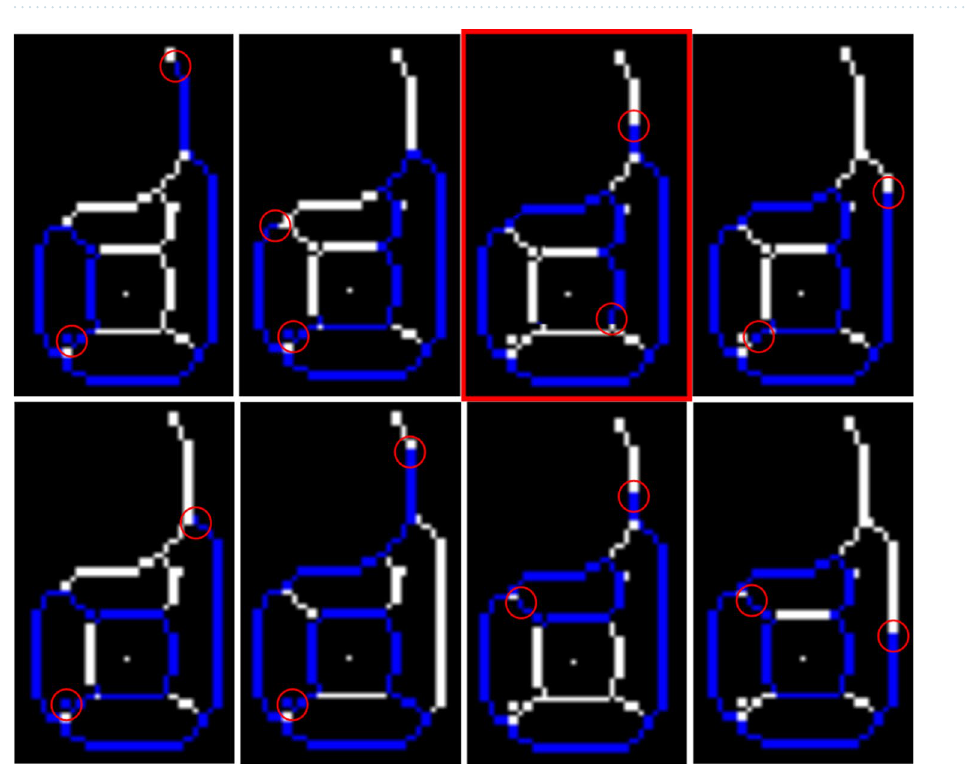
Figure 7. Possible rolled skeleton combinations. Possible rolled skeleton solutions (blue) using the proposed skeletonising method that will be evaluated by an optimiser to obtain the best possible solution marked by the red